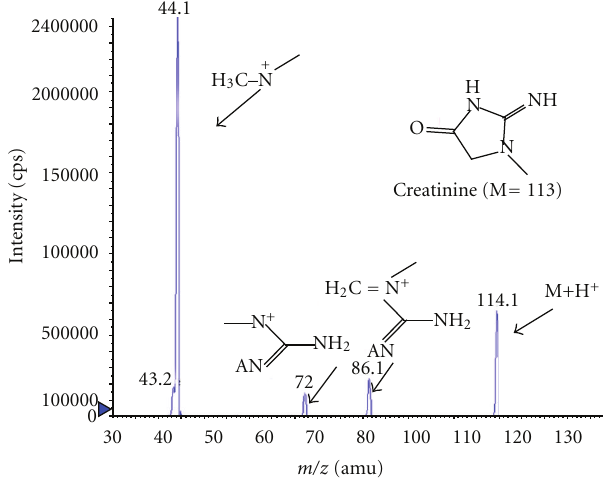
Figure 1: Mass ESI tandem mass spectra of creatinine with product ion scan ( m/z